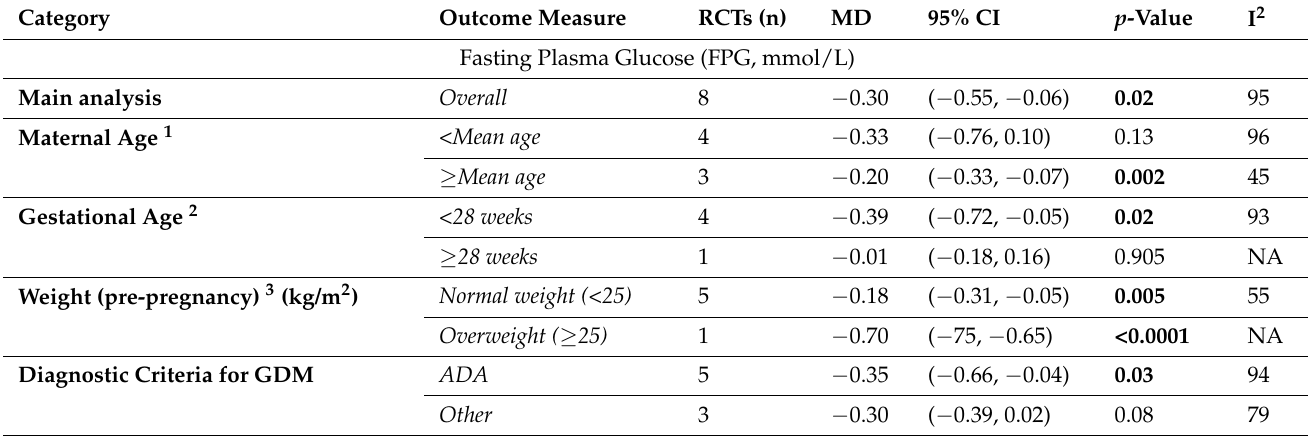
Table 4. Subgroup analysis of nutritional supplement vs. control interventions.